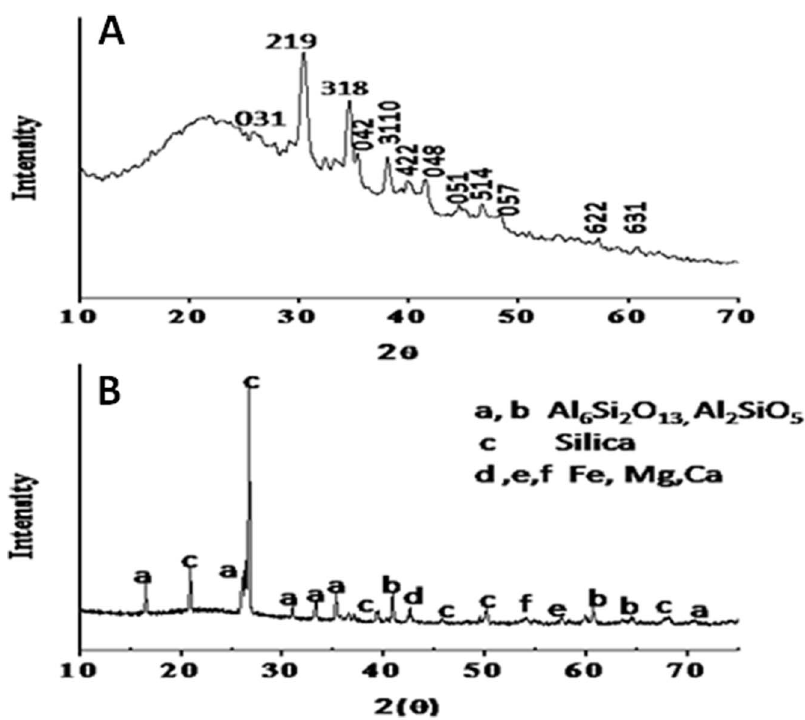
Figure 4. X-ray Diffraction (XRD) analysis of bioleached silica nanoparticles obtained after reacting Fly-ash with Fusariumoxysporum for 24 h (A) and Fly-ash powder (B).